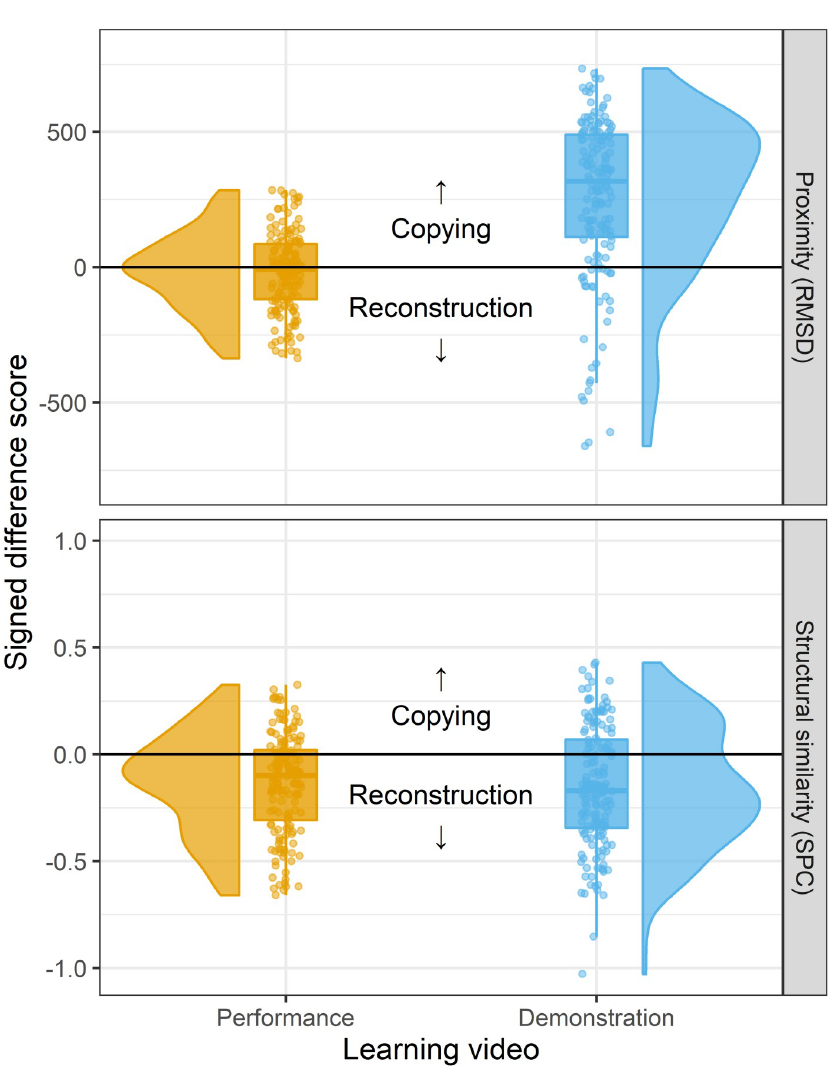
Fig 5. Raincloud plots showing the results of the proof-of-concept empirical study. Points show signed difference scores between proximity (top) and similarity (bottom) metrics of each learner’s reproduction relative to the Learning and Original seeds, such that positive values indicate support for a copying process while negative values indicate support for reconstruction. Results are shown separately for Learning from Performance (orange, left) and Learning from Demonstration conditions (blue, right). Boxplots and half-violin plots show the distribution of difference scores. scores: people who scored high on the scale subtest were more likely to copy the relative timing (ß = 0.89, SE = 0.40, t(24.01) = 2.22, p = .036), but this was not true for the keys subtest timing (ß = -0.17, SE = 0.34, t(23.99) = -0.49, p = .632) or, importantly, the beats subtest, which was the only test relating to musical sensitivity to timing (ß = -0.38, SE = 0.27, t(24.00) = -1.40, p =